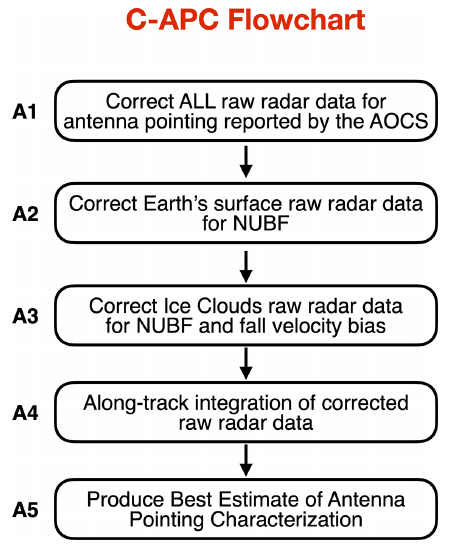
Figure 7. The C-APC algorithm